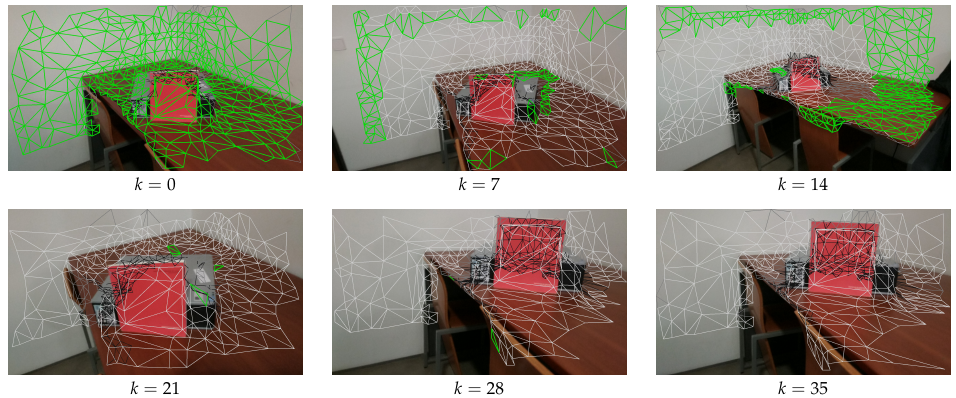
Figure 13. Propagation criteria for selecting the faces; Color notation is the same as in Figure